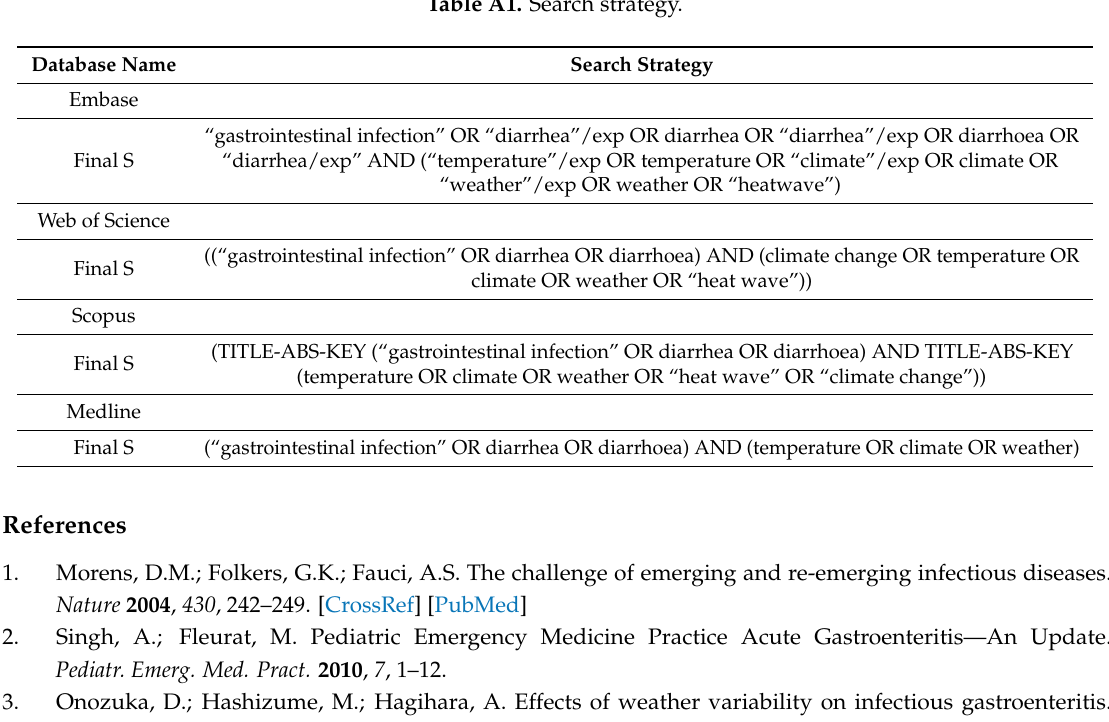
Table A1. Search